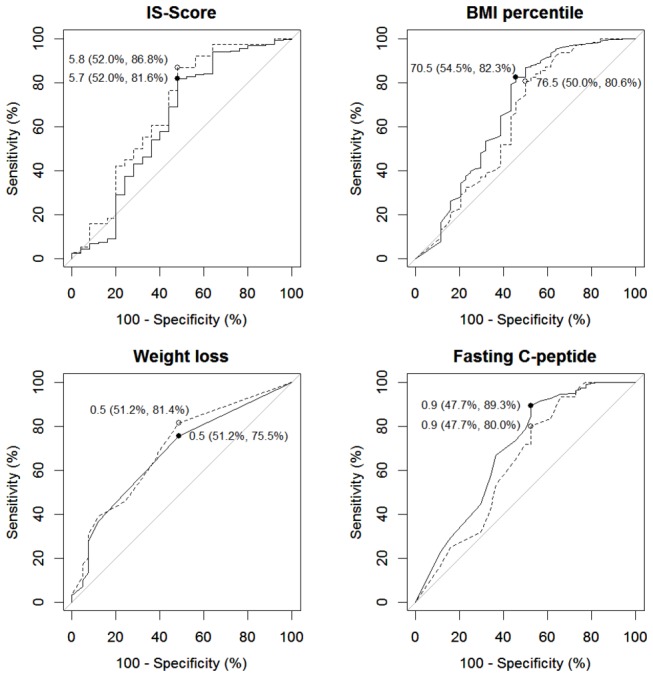
Receiver operating characteristic curves for number of islet autoantibodies status (dashed line: one compared to none, solid line: multiple compared to none) according to Insulin Sensitivity (IS) Score, BMI percentile, weight loss before diagnosis, and fasting C-peptide.Optimal cut-off values determined by the

Youdenindex

 with specificity and sensitivity in parentheses are displayed.